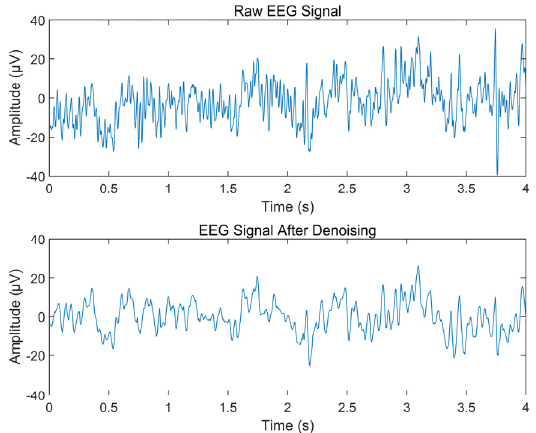
Figure 6. Time Domain Waveforms Before and After Denoising.